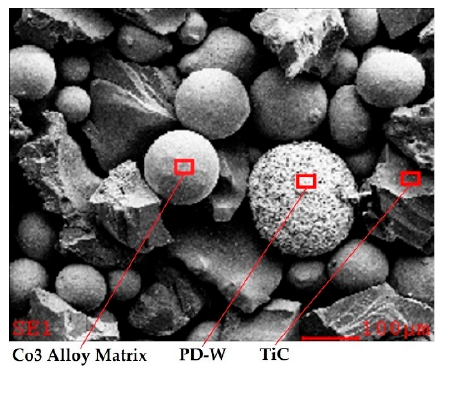
Table 5. Cladding parameters of the plasma transfer arc welding (PTAW) metal deposition of the surface layers on AISI 4715 steel.